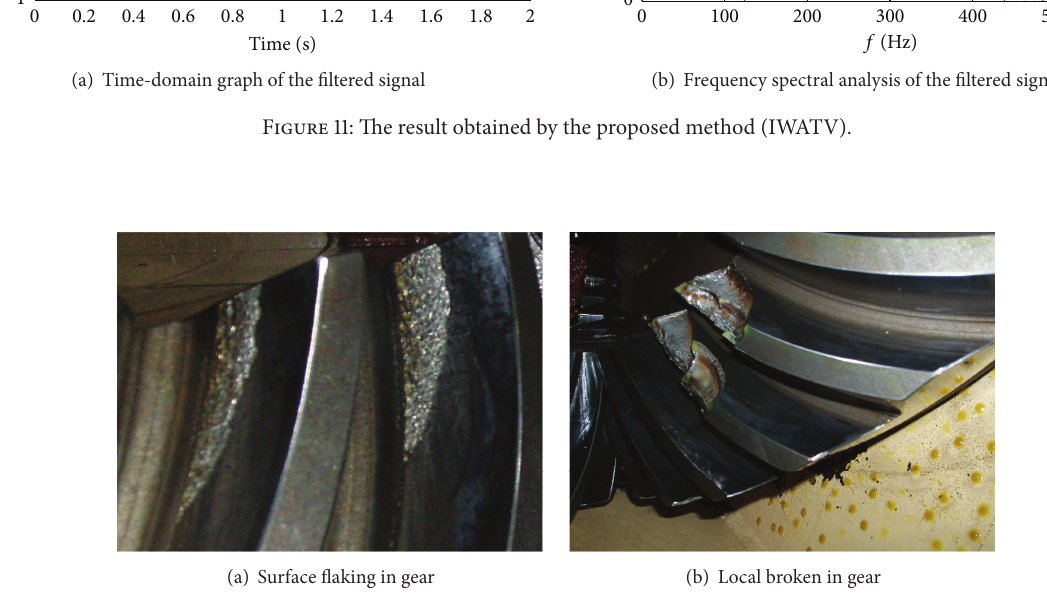
Figure 12: Picture of faulty gear after